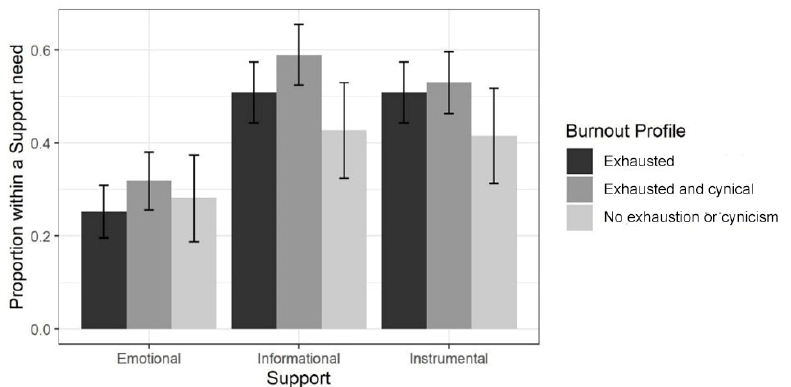
Figure 4. Support needs within burnout profiles. The lines indicate 95% confidence intervals that were calculated using the asymptotic method (normal approximation).